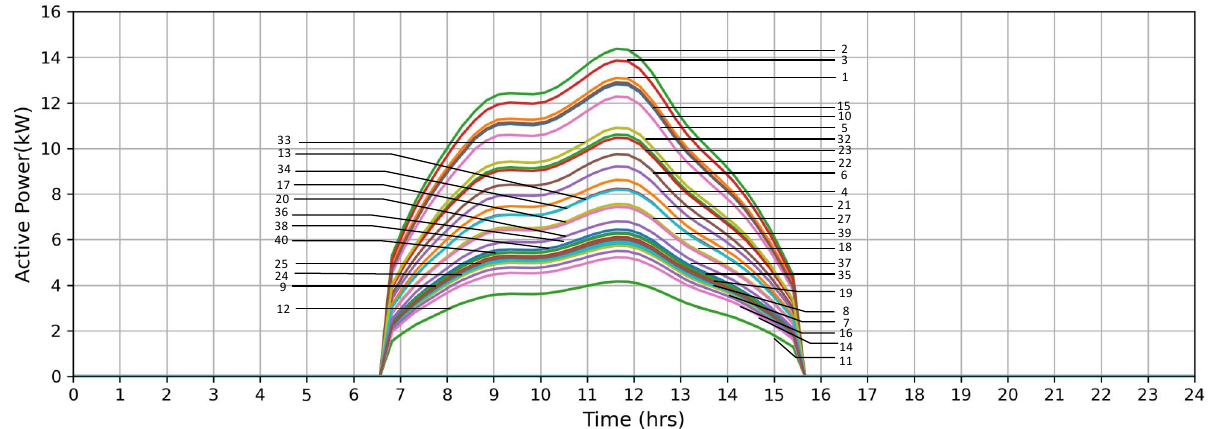
Figure 12. Active power variation of all the PV units during the assessment